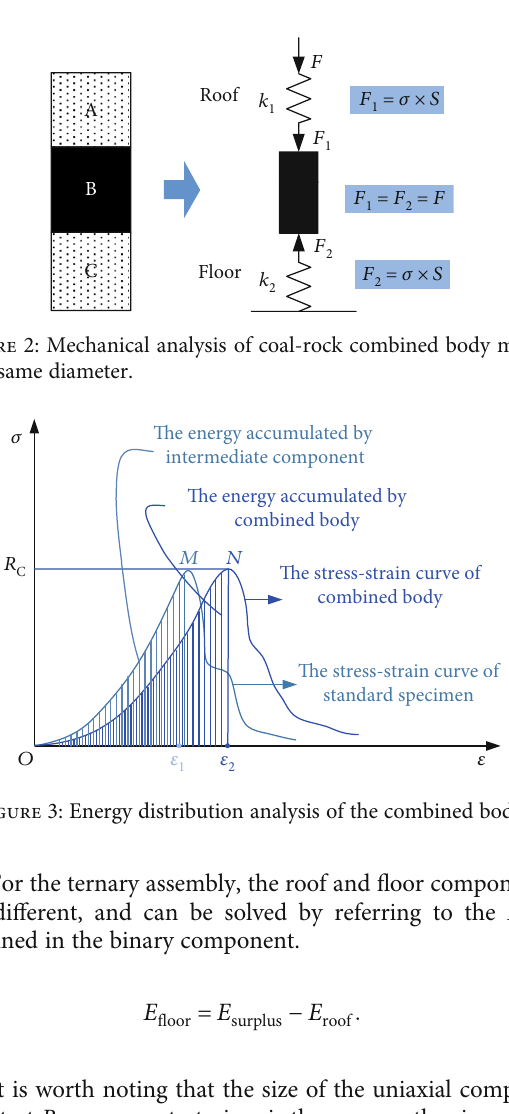
Figure 1: Model of the same diameter coal-rock combined body.